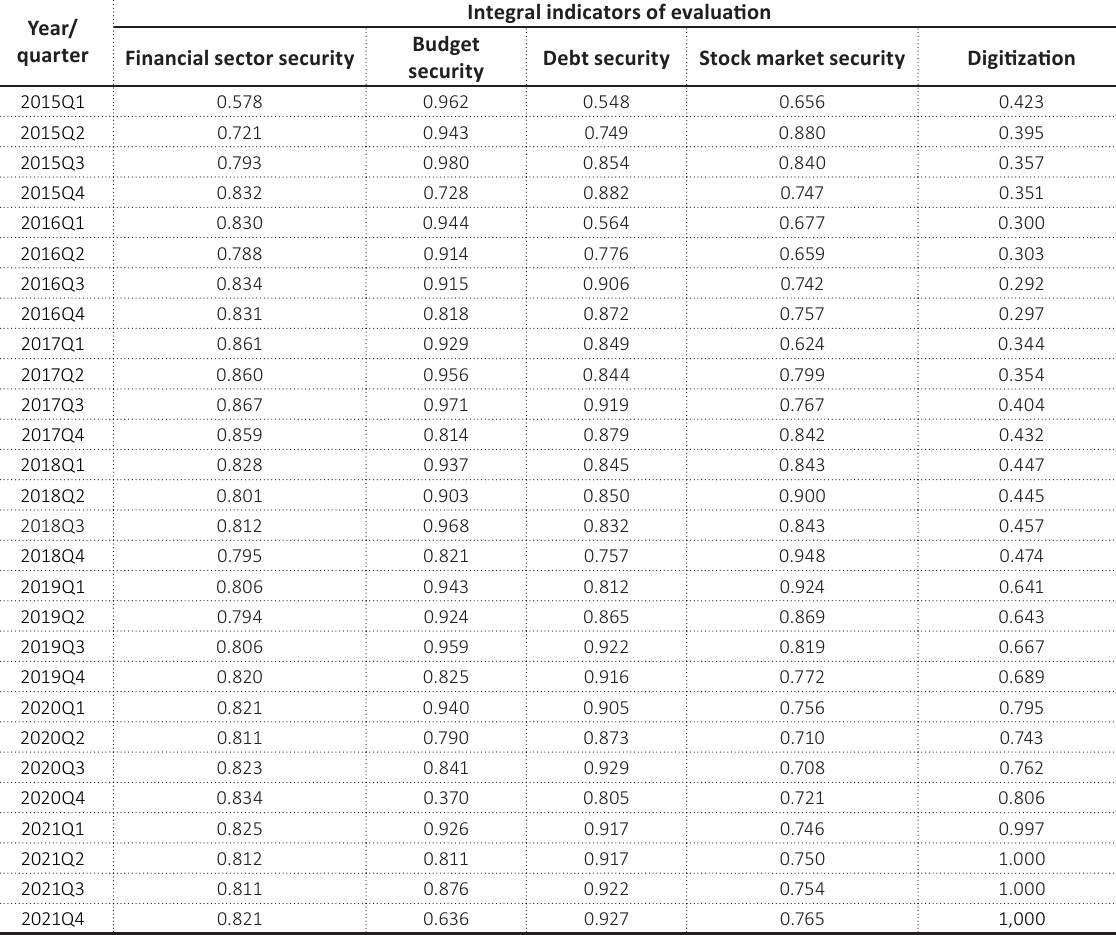
Table 1. Integral indicators for assessing financial sector security, stock market security, debt and budget security, as well as